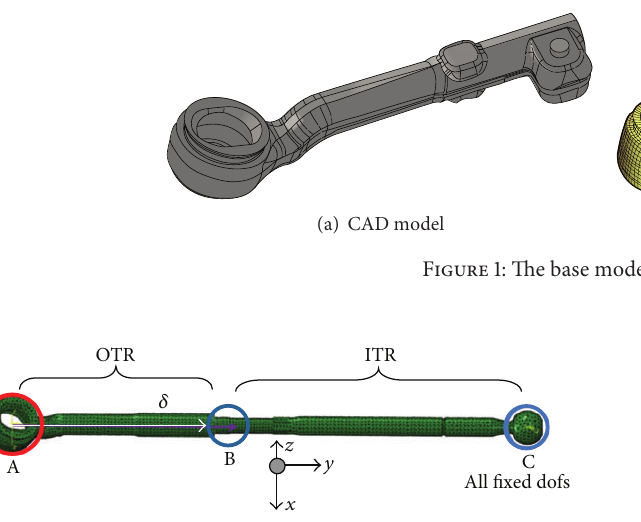
Figure 2: Loading condition for buckling analysis.